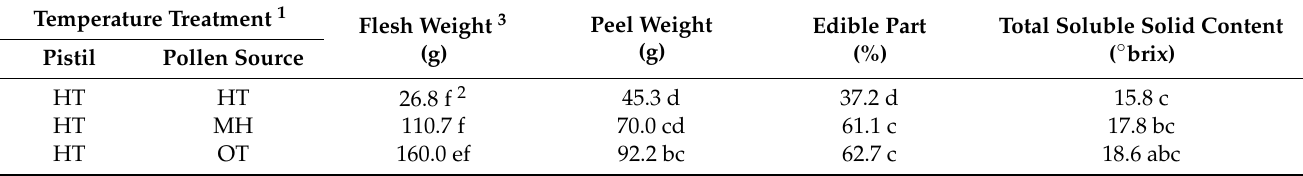
Table 3. Comparison of fruit characteristics, including flesh weight, peel weight, edible part, and total soluble solid content from self-pollination or mutual cross combinations by HT, MH, and OT treatments in “Da Hong” pitaya at harvest in